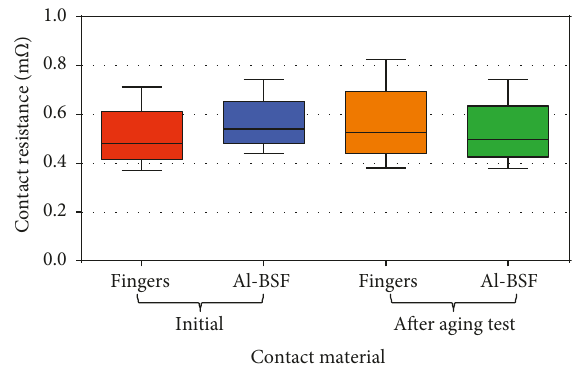
Figure 14: The wire contact resistances to fi ngers and Al-BSF, which were tested initially and after aging